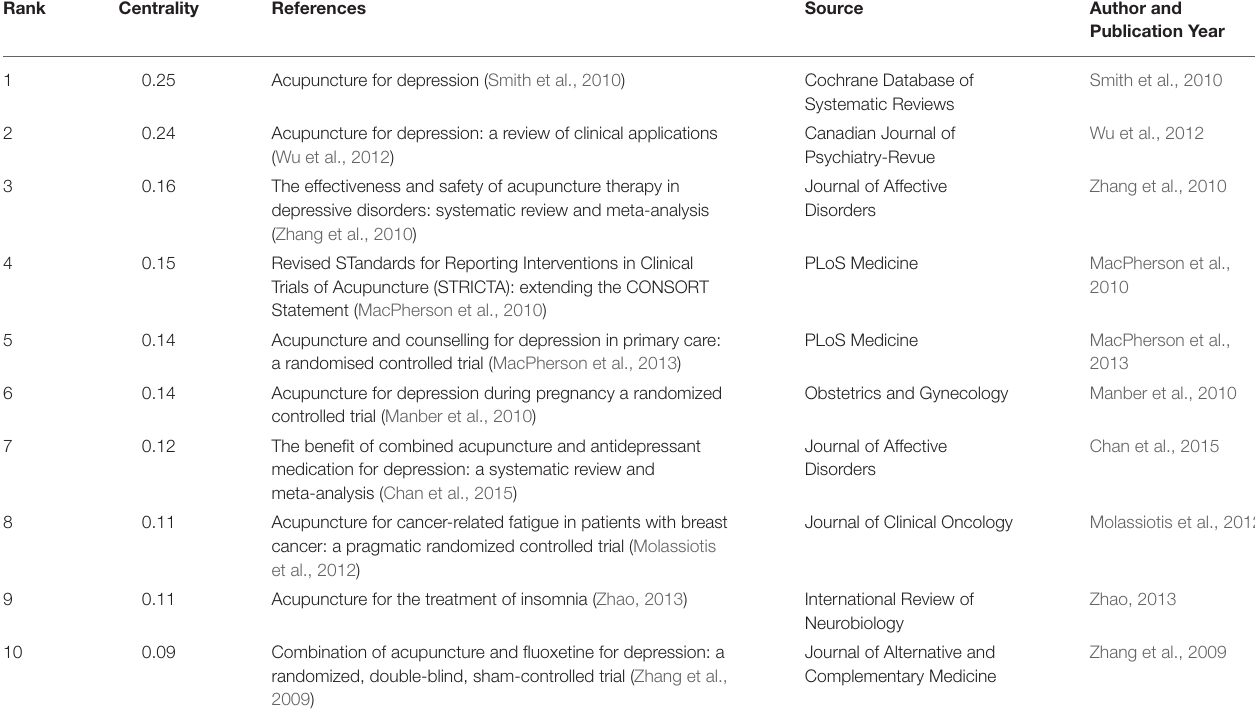
TABLE 7 | Top 10 centrality of cited references related to acupuncture on depression.